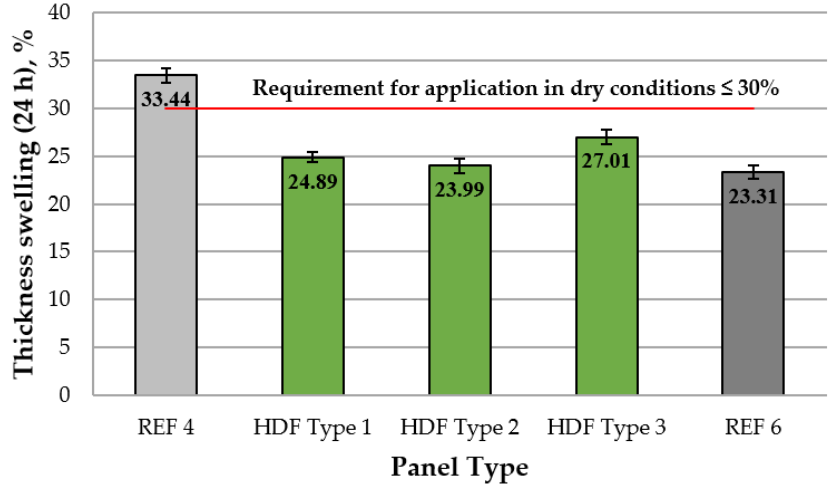
Figure 3. Thickness swelling (24 h) of HDF panels produced. REF 4: 4% UF resin; HDF Type 1: 4% UF resin and 4% ALS; HDF Type 2: 4% UF resin and 6% ALS; HDF Type 3: 4% UF resin and 8% ALS; and REF 6: 6% UF resin. (Error bar represents the standard deviation, and the red line represents the EN 622-5 standard requirement for load-bearing panels for use in dry conditions